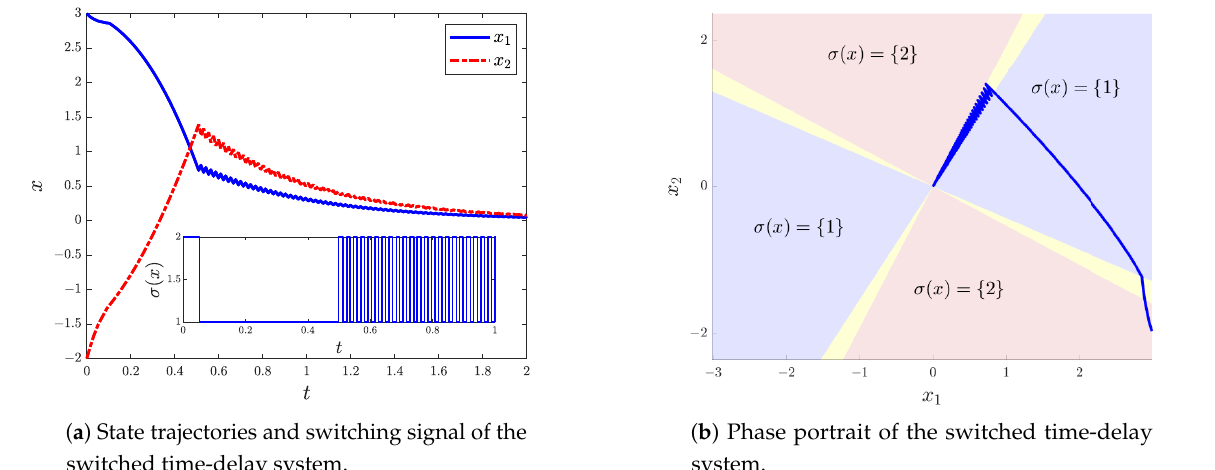
Figure 2. Example 1: evolution of the switched system under the modified min-projection switching